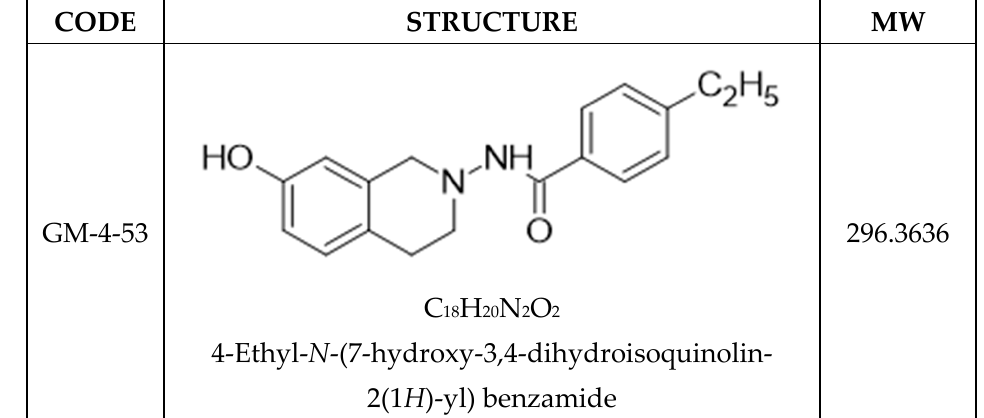
Figure 1. Chemical Structure of GM-4-53.